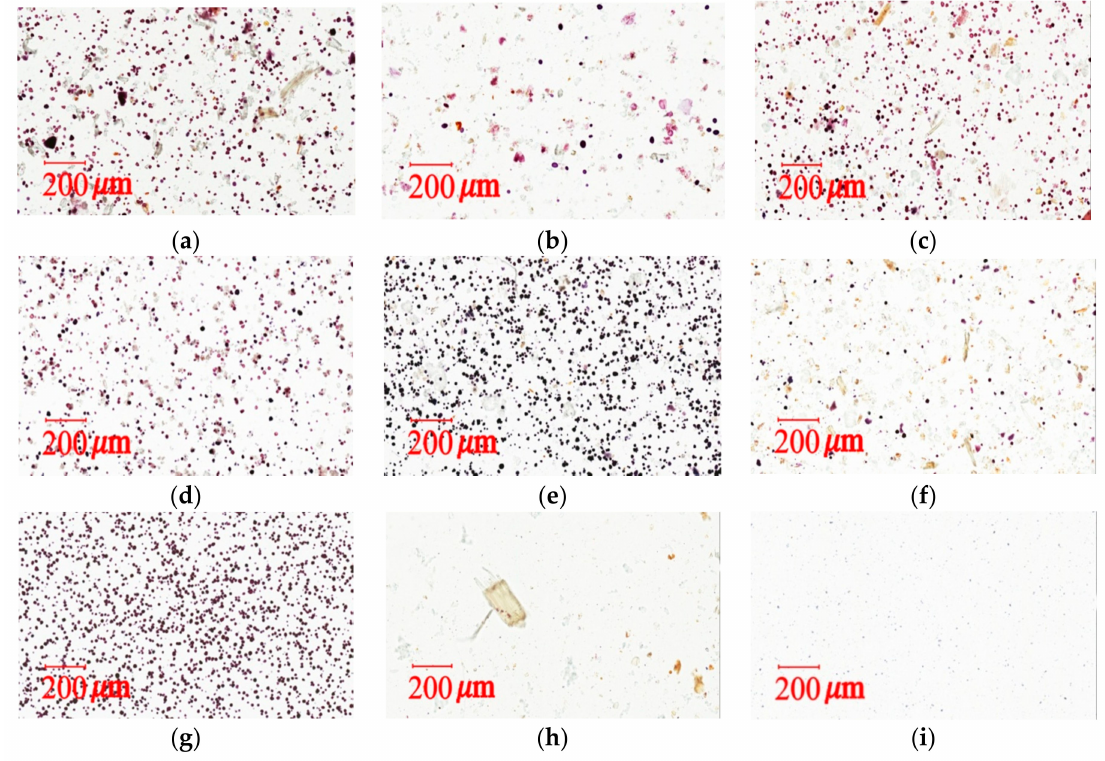
Figure 5. Light microscopy photographs of iodine–KI staining: ( a ) herbal pharmaceutical product